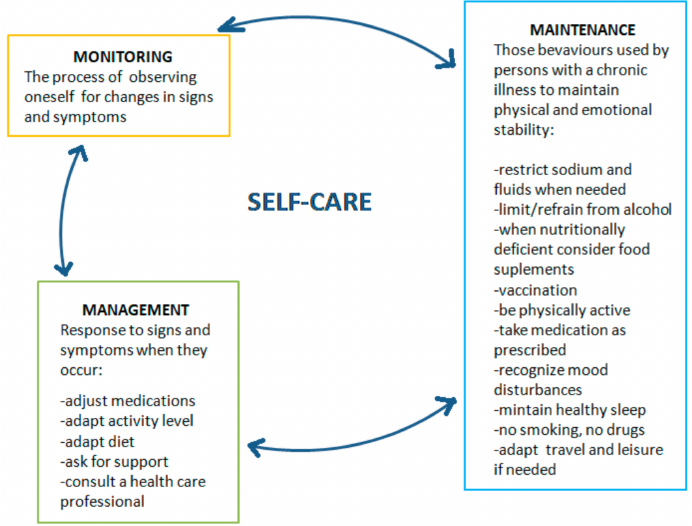
Figure 1. Theory of self-care in heart